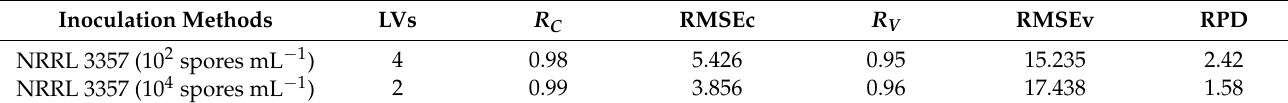
Table 5. AFB 1 prediction results using key wavelengths.